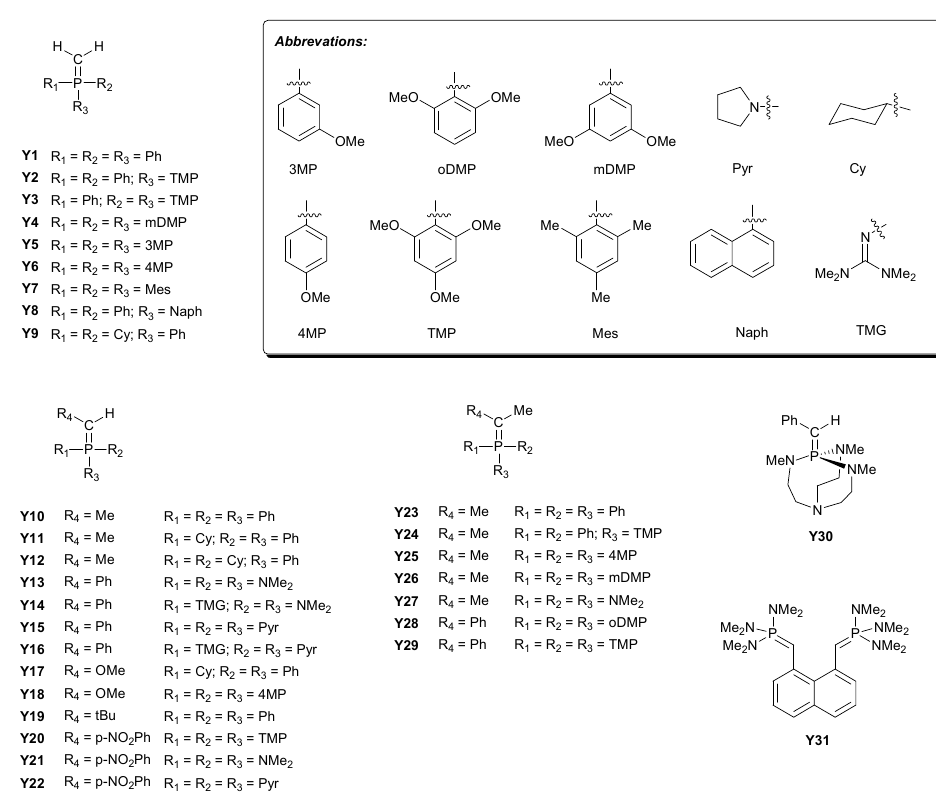
Scheme 3. Structures of ylides Y1 – Y31 (carbon bases) with known p K a in acetonitrile.